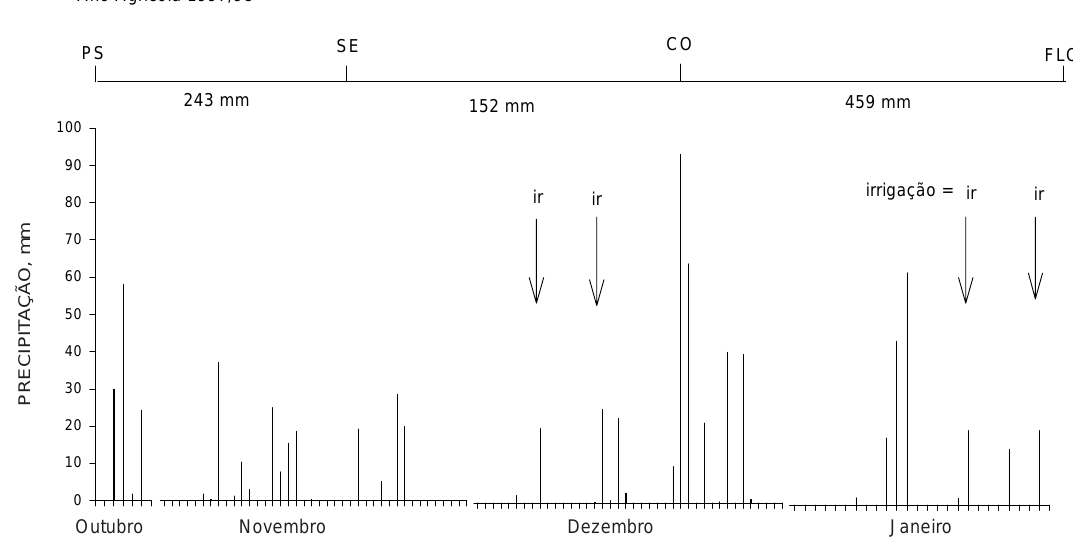
Figura 2. Distribuição das chuvas no período da aplicação do N em pré-semeadura (PS) até o florescimento (FLO) do milho no segundo ano agrícola.